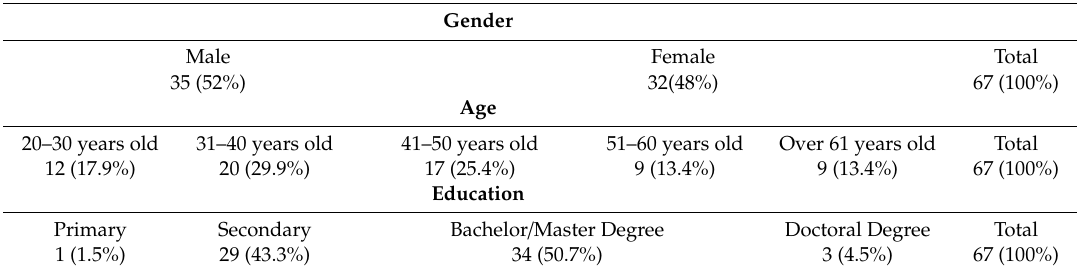
Table 2. Control group—gender, age and